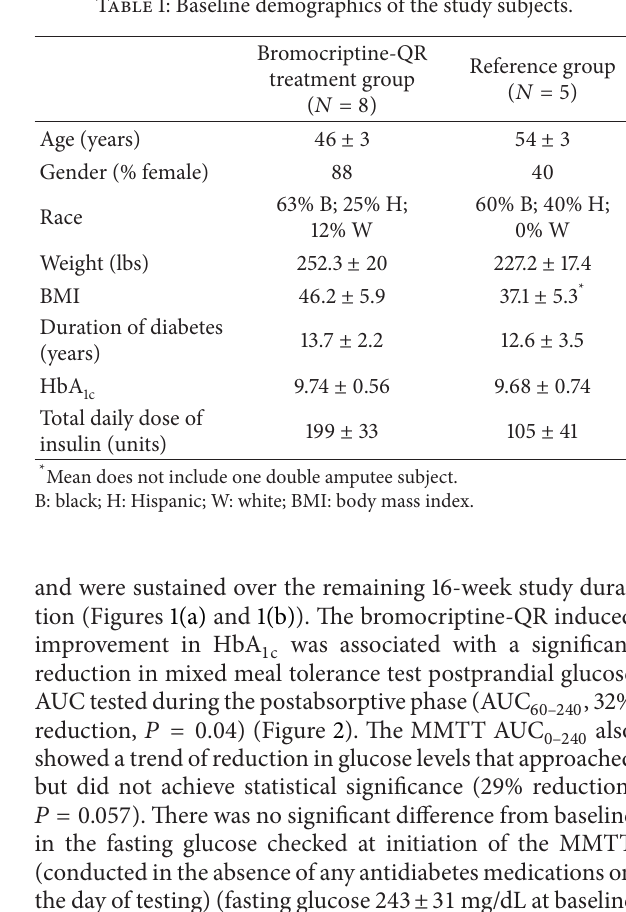
Table 1: Baseline demographics of the study